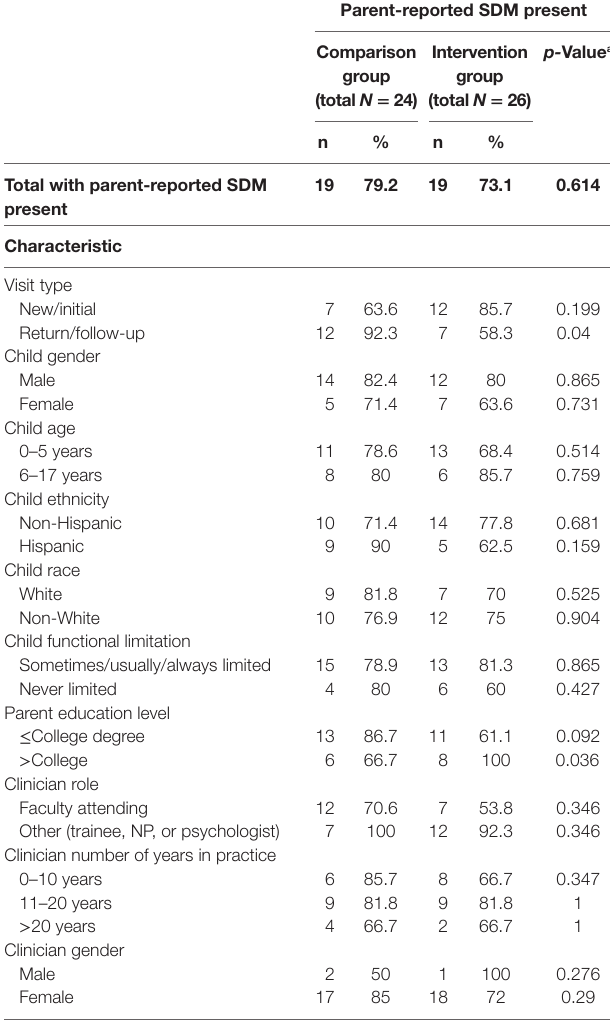
Table 2 | Bivariate analysis. Table 1 | Descriptive characteristics of the visit, child, parent, and